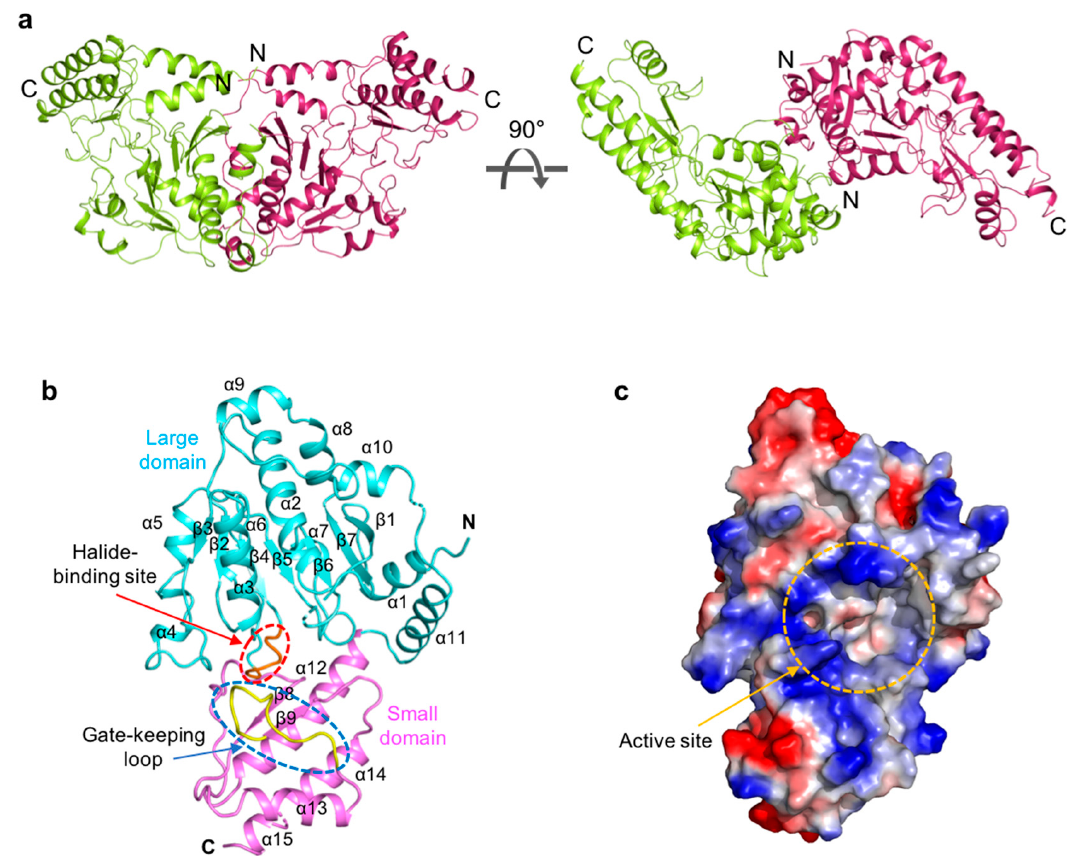
Figure 1. Overall structure of Saccharomyces cerevisiae phosphoserine aminotransferase ( Sc PSAT). ( a ) Schematic drawing of the dimeric structure of Sc PSAT. The two monomers are indicated in green and purple, respectively. The right panel depicts 90 ◦ rotation along the X-axis. ( b ) The monomeric structure of Sc PSAT consisting of the large domain (cyan), small domain (pink), gate-keeping loop (yellow, highlighted with a blue-dashed oval), and halide-binding site (red, highlighted with a red-dashed oval). ( c ) Electrostatic surface representation of the Sc PSAT monomer, indicating the negatively charged (red) and positively charged (blue) surfaces and the active site (orange-dashed circle).